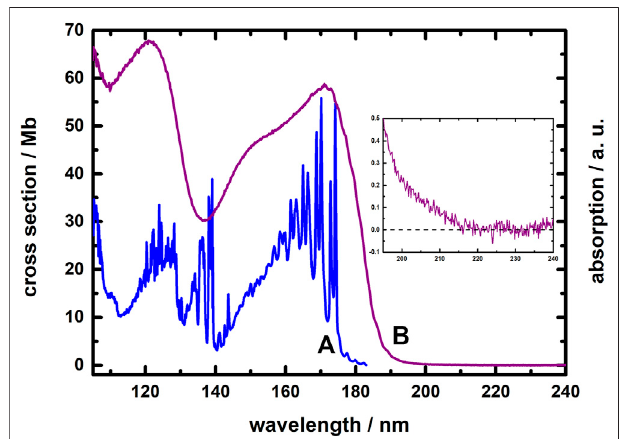
FIGURE 1 | Absorption spectra of C (A) gaseous phase in the 2 H 4 ; wavelength region 105 – 185 nm at 298 K; (B) solid state in the wavelength region 105 – 240 nm near 10 K. The insert shows the threshold region of solid C 2 H 4